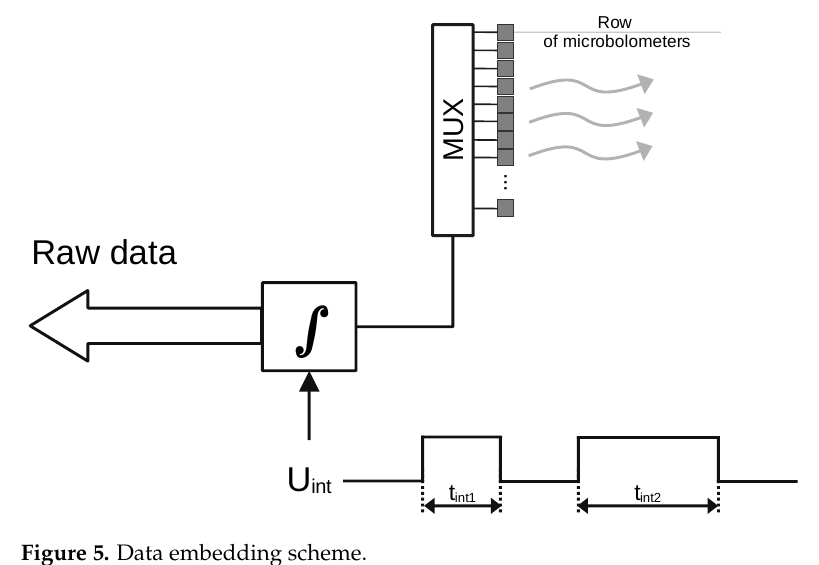
Figure 5. Data embedding scheme.